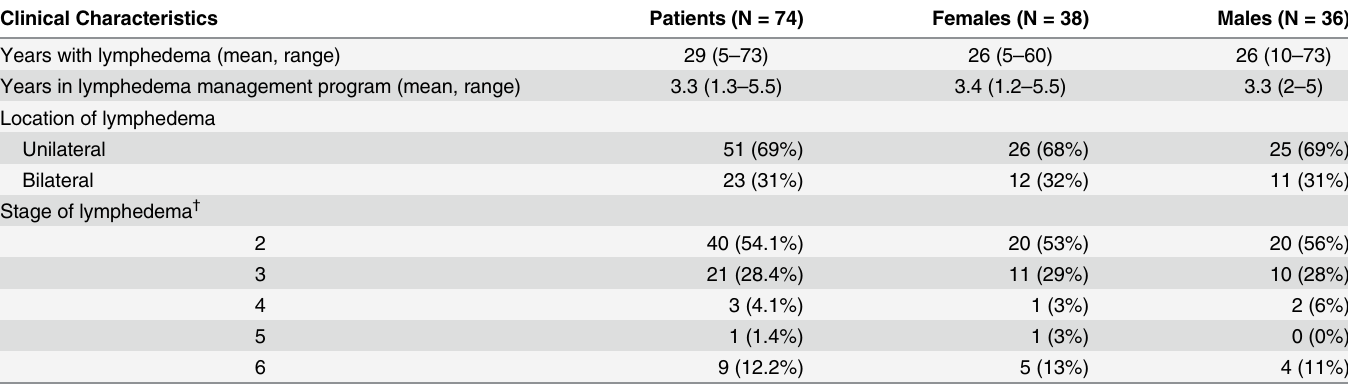
Table 2. Clinical characteristics of focus group patients (N =